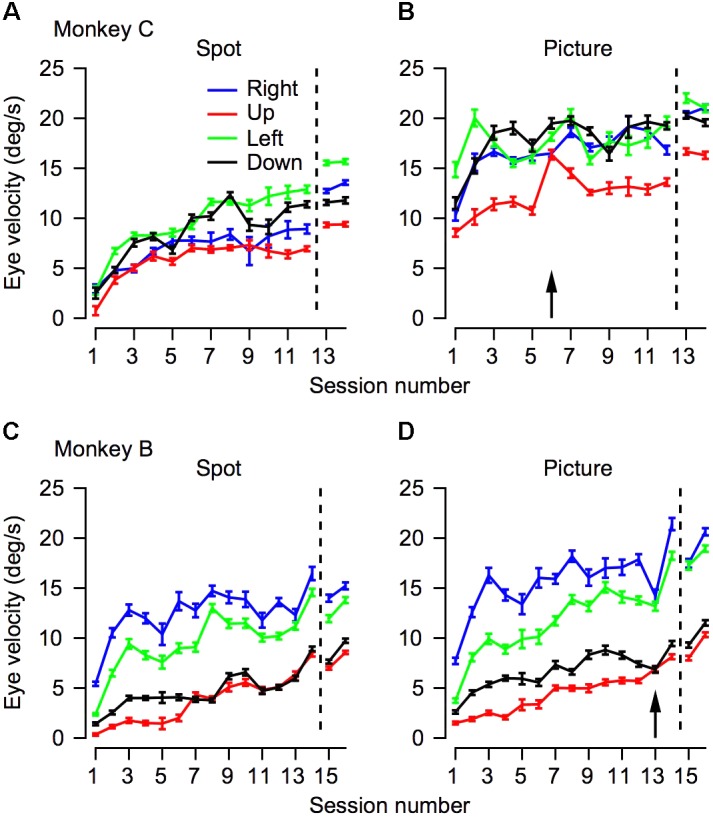
The progression over training days for eye velocity during pursuit initiation. The horizontal axis represents the session number. Values to the right of the vertical dotted line were recorded after extensive training on pursuit tasks. The vertical axis represents the average eye velocity at 250 ms after target motion onset. The top (A,B) and bottom (C,D) plots shows data for Monkeys C and B. Different columns correspond to the different target conditions and different colors represent different movement directions. The arrows in (B,D) mark the sessions in which we switched to the second monkey picture.